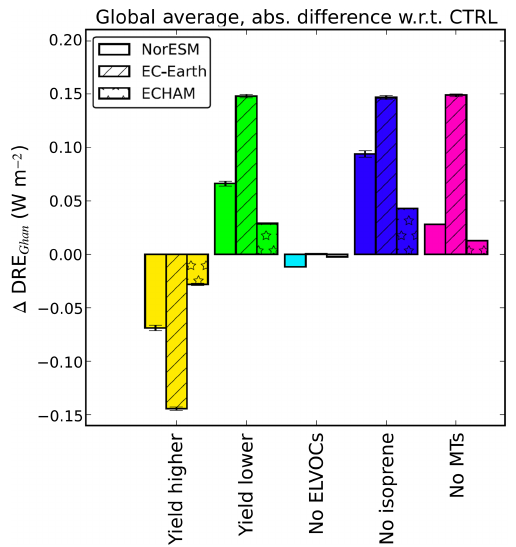
Figure 5. Bar plots of the average direct radiative effect (DRE Ghan ) difference between each sensitivity simulation and the CTRL simu- lations. Coloured bars indicate a significant difference in the simula- tion averages with a 95% confidence interval. The error bars denote the standard error of mean of the yearly